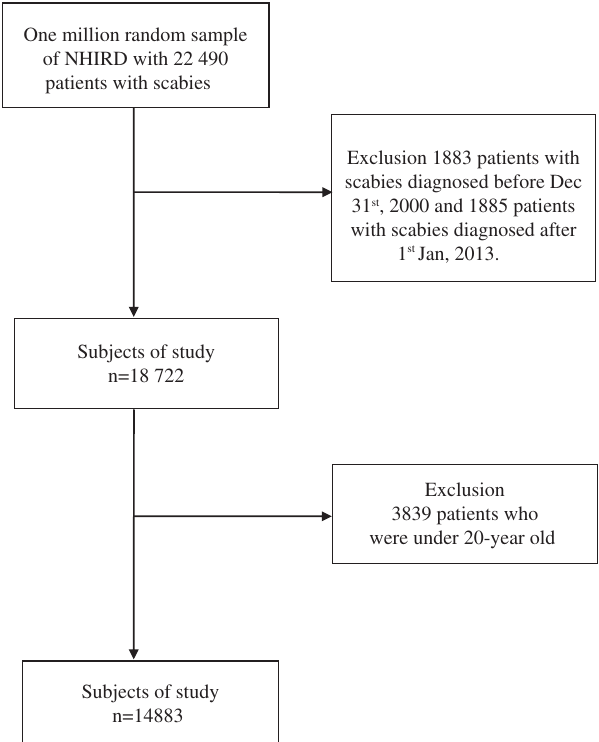
Figure 1. Flowchart of collection of study subjects of National Health Insurance Research Database (NHIRD), from January 2000 to December